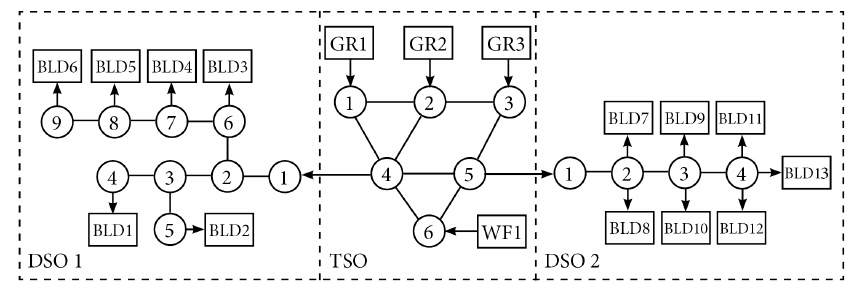
Figure 3. Network topology of the MPC problem, indicating the grid structure, generators (GR) buildings (BLD) and wind farm